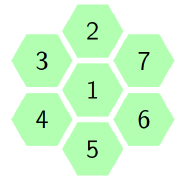
Figure 2. Hexagonal tiling under small cell